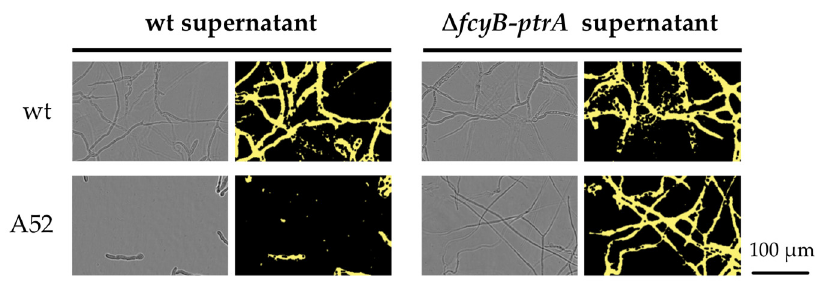
Figure 2. Representative images showing the growth promotion of the reporter strain A52 using A. fumigatus wt ( top ) and ∆ fcyB-ptrA ( bottom ) culture supernatants collected after 18 h growth. wt was used as a normal growth reference. Phase images ( left ) are shown for better visualization together with the respective confluence mask images ( right